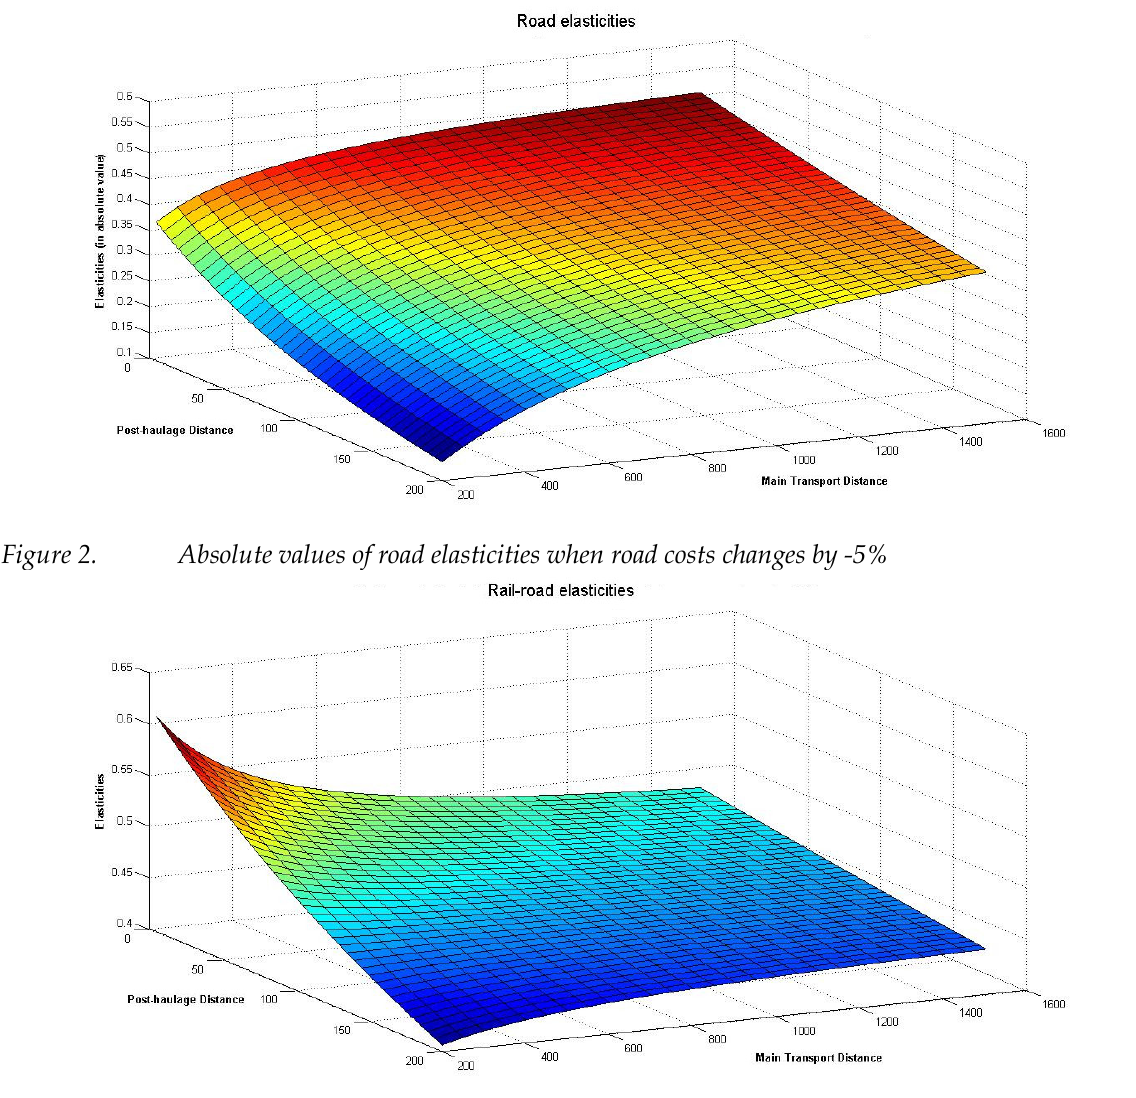
Figure 3. Rail-road elasticities when road costs changes by